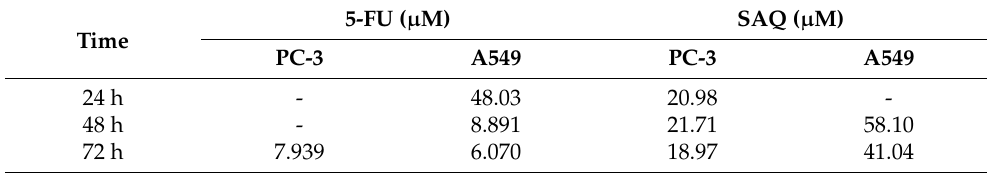
Table 4. IC 50 values for A549 and PC-3 cells after exposure to 5-FU and SAQ for various time points.